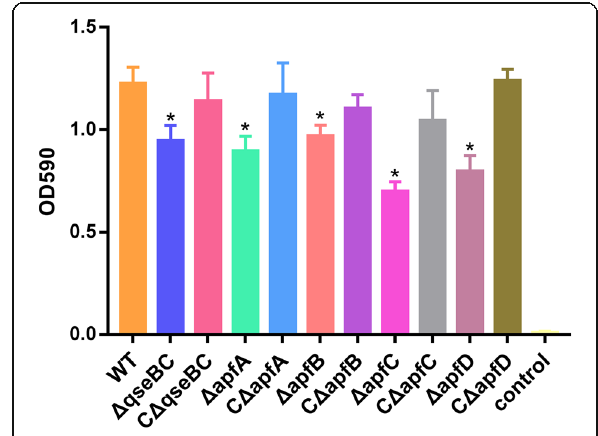
Fig. 5 Quantitative determination of biofilm formation. WT S4074, Δ qseBC , Δ apfA , Δ apfB , Δ apfC and Δ apfD strains were grown in BHI at 37 °C. OD 590 of the bacterial biofilm were measured after 72 h of incubation. Data are shown as mean ± SD ( N = 3). * P <